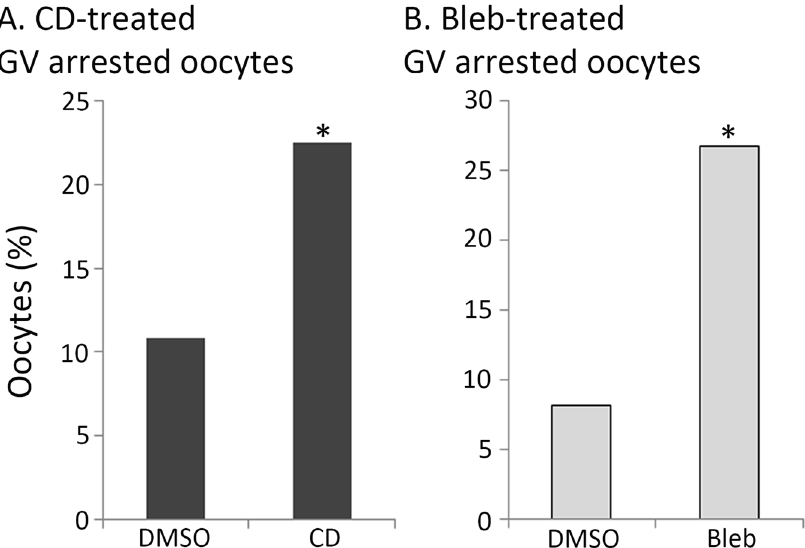
Figure 5. Polymerization and contractility of actin filaments support GVBD. GV oocytes were incubated for one hour at 37 °C at an atmosphere of 5% CO 2 in the presence of 1 µ M milrinone and 5 µ g/ml cytochalasin D (CD; A ), 50 µ M blebbistatin (Bleb; B ) or of an equal volume of vehicle (DMSO). Oocytes were washed out of milrinone and incubated for 3 more hours, to allow GVBD, in the presence of the inhibitors. The